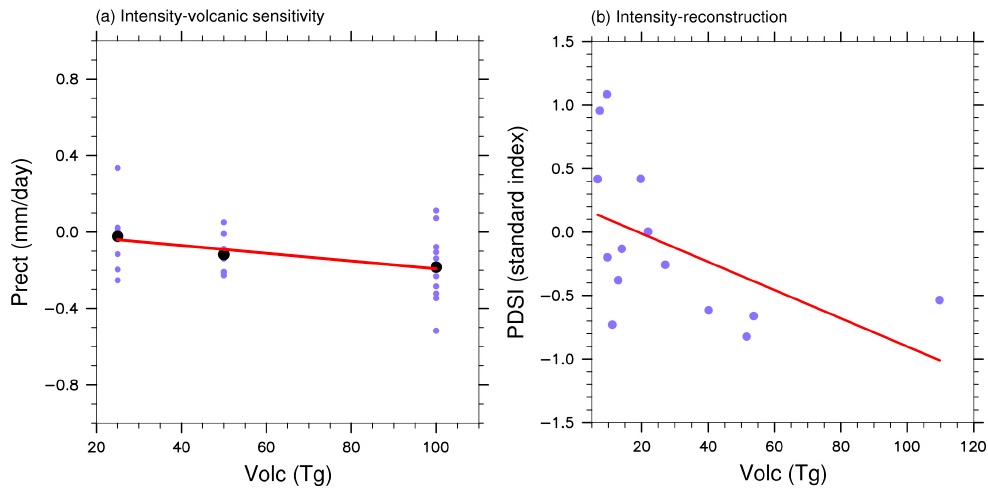
Figure 2. ( a ) The scatter plots of the changes of volcano-induced drought intensity and the magnitudes of volcanic eruptions in the three groups of sensitivity experiments (purple dots), and corresponding ensemble means of drought intensity after 25 Tg, 50 Tg, and 100 Tg volcanic eruptions (black dots). The X-axis represents the magnitudes of volcano eruptions (Tg), and the Y-axis represents the average precipitation anomalies (unit: mm/day) after volcanic eruptions (years 0–9). The red line is the linear regression between the volcano-induced drought intensity and magnitudes of volcanic eruptions. ( b ) is similar to ( a ), but for the results of the reconstructed PDSI after volcanic eruptions.